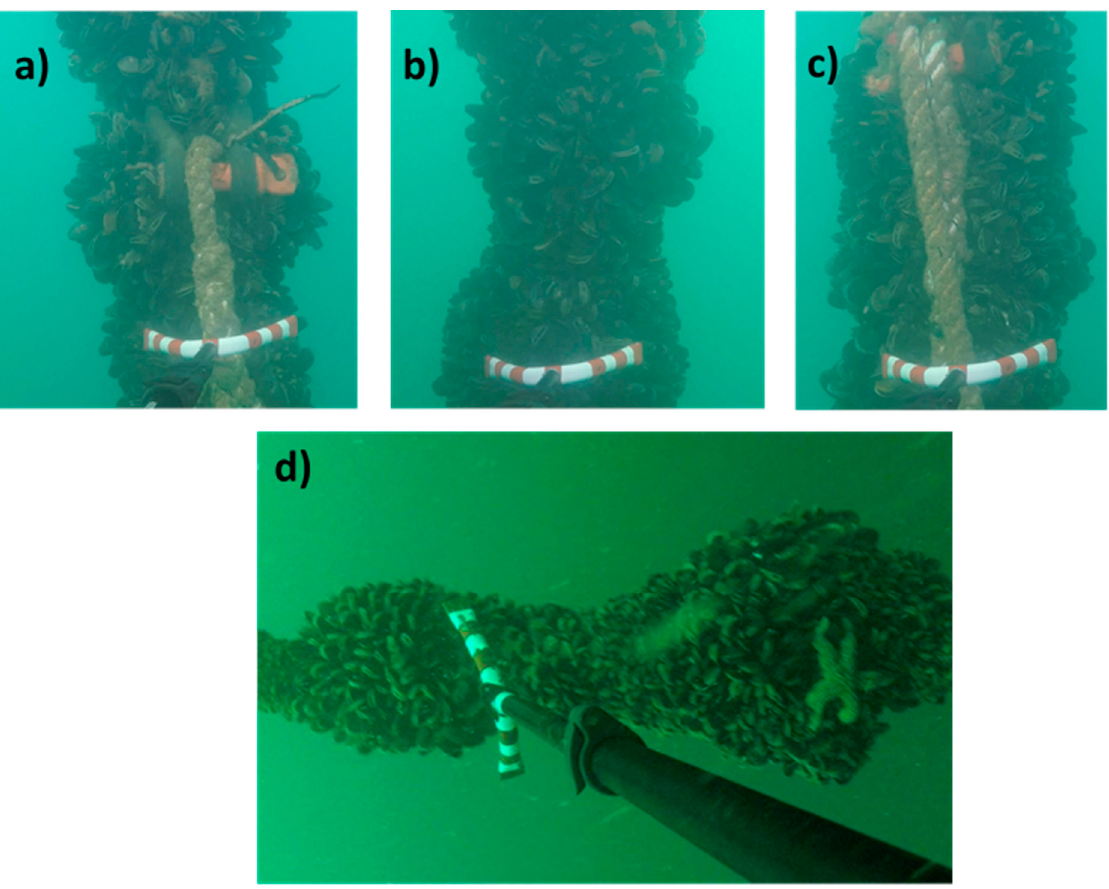
Figure 7. Three photographs of a mooring chain fully coved by mussels on SEMREV test site ( a – c ) and UN@SEA platform ( d ).